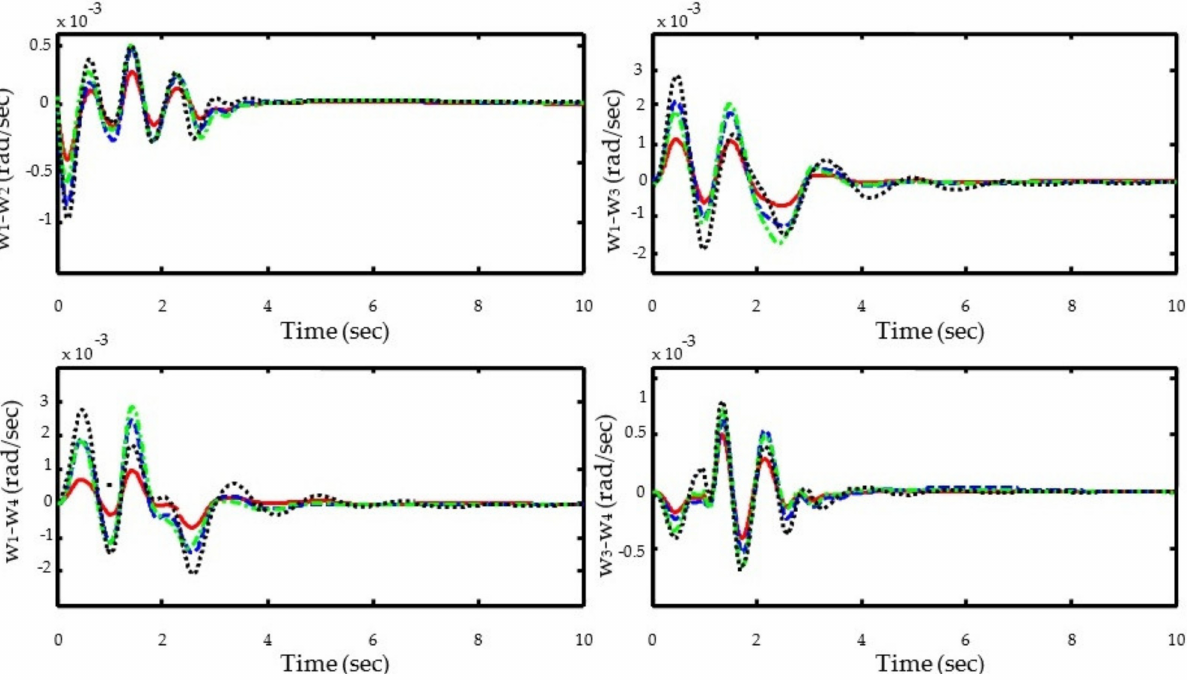
Figure 7. Angular velocity deviation for the first scenario for heavy load; proposed (red line), BFA (blue dashed line), GA (green dash–dotted line), classic (black